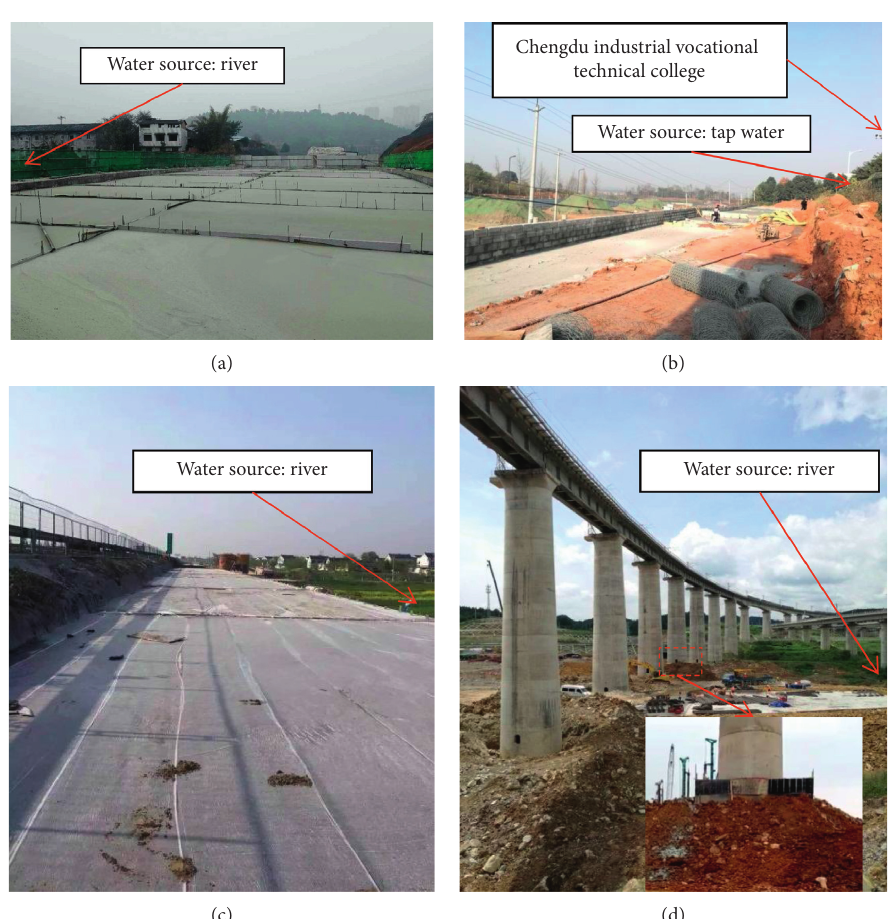
Figure 14: Overview of the test sites: (a) project 1 (fill on the top of the arch bridge), (b) project 2 (backfill behind the wall), (c) project 3 (widening of expressway), and (d) project 4 (backfill of high-speed